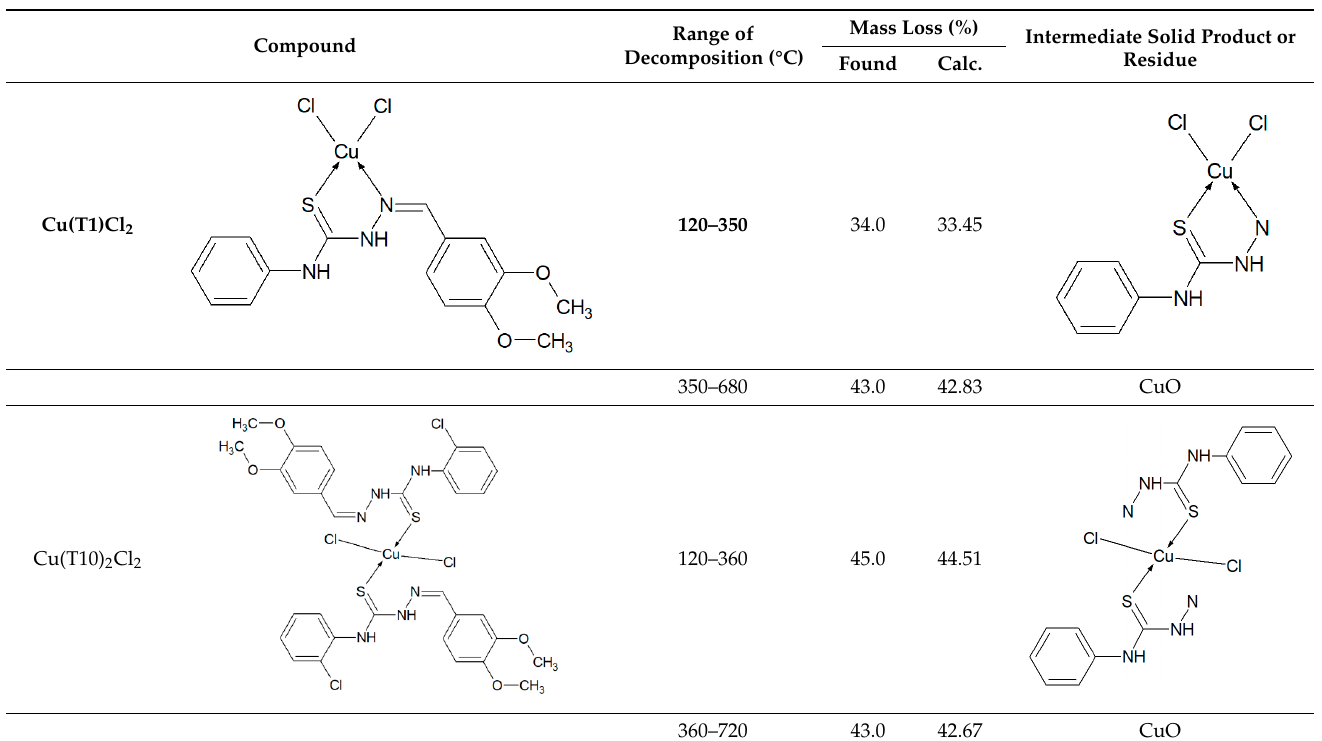
Table 2. TG-DTG analysis data for decomposition processes of copper(II) complexes.